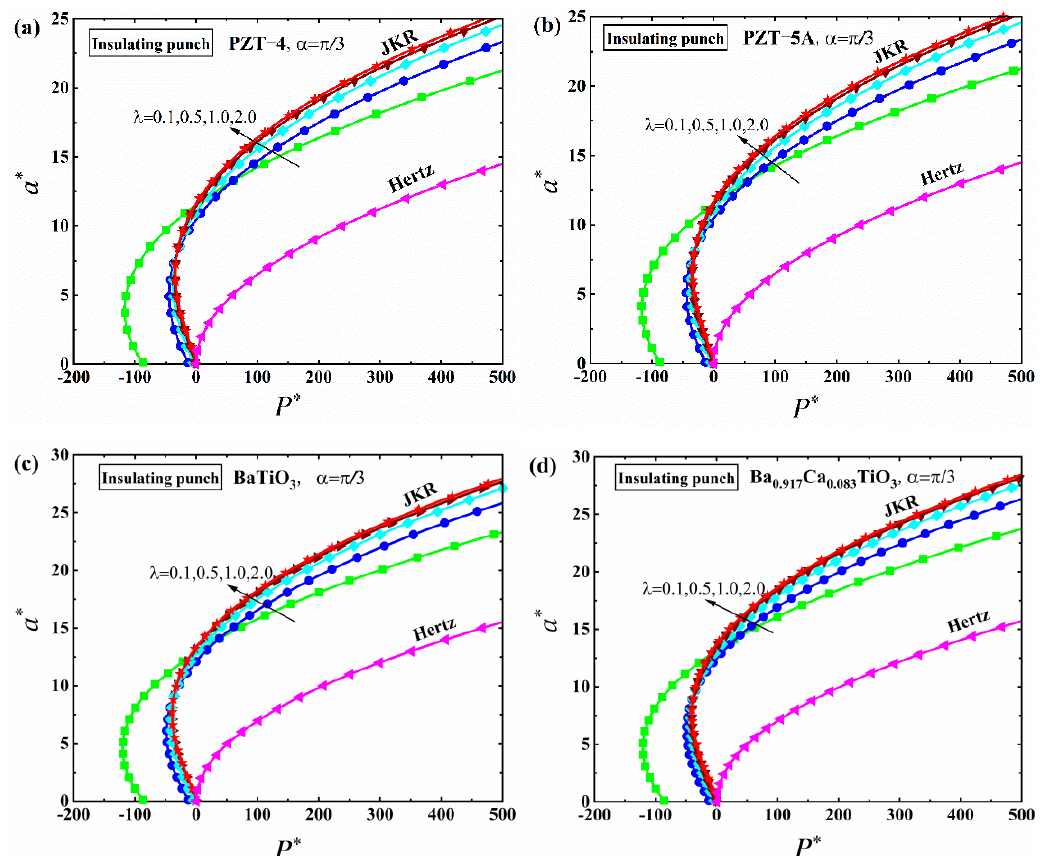
Figure 15. The dimensionless contact radius, a ∗ , as a function of the dimensionless indentation force, P ∗ , under the action of an insulating punch for the M-D model. ( a ) PZT-4. ( b ) PZT-5A. ( c ) BaTiO 3 . ( d ) Ba 0.917 Ca 0.083 TiO 3 .